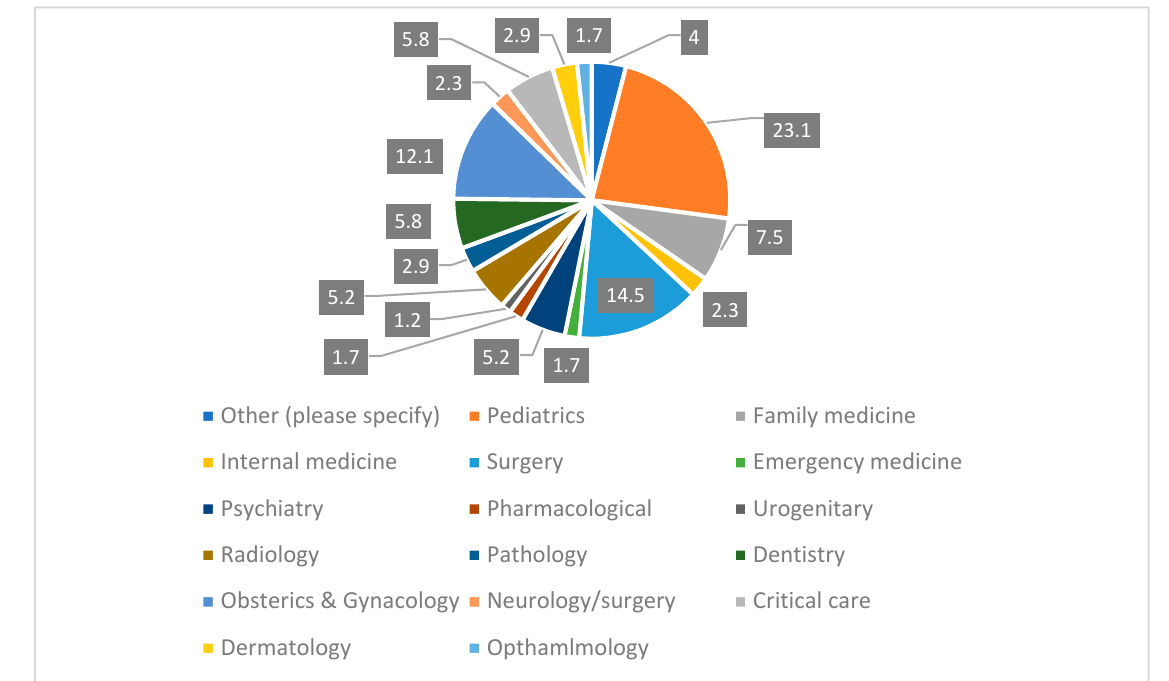
Figure 1. Faculty members specialty (in %).